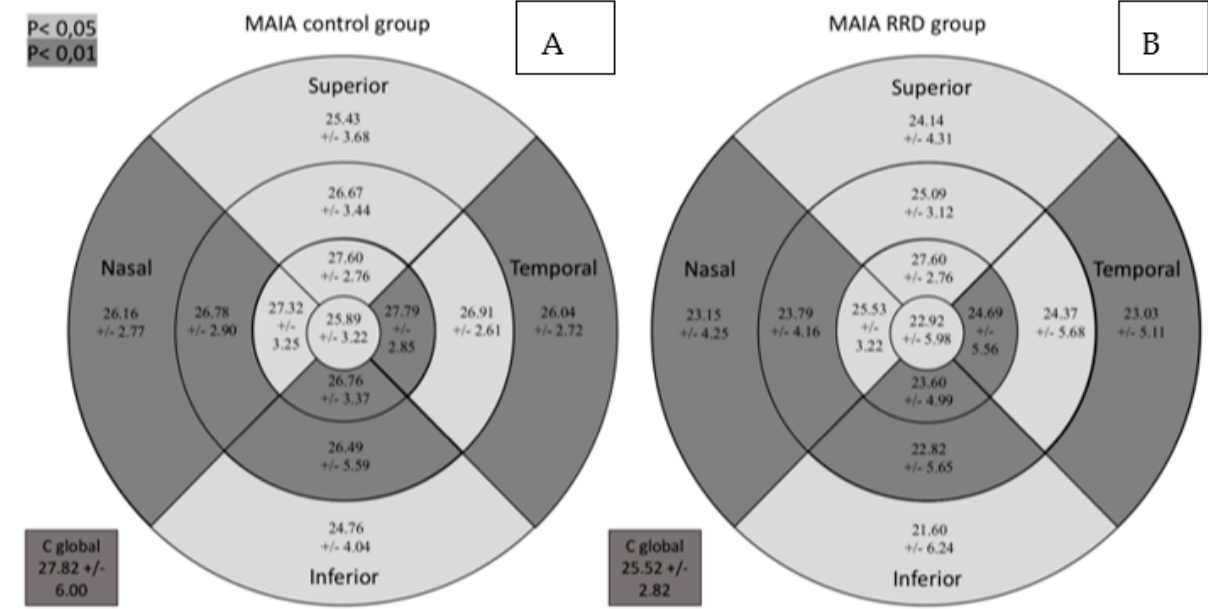
Figure 3. Comparative results between the control group ( A ) and the group of patients with RRD ( B ) for retinal sensitivity measured by MAIA in dB in the study sectors. MAIA: macular integrity assessment; ETDRS: Early Treatment Diabetic Retinopathy Study; RRD: rhegmatogenous retinal detachment; C global: central global. Significant comparisons between the groups ( p < 0.05) are presented in gray background ( p < 0.05) or darker gray background ( p < 0.01).